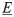
Firing and bursting activity of (4) as a function of z.Top panel shows the values of median ASDRs calculated across 1000 of adjacent and non-overlapping intervals of t (see Methods), each containing k = 30 elements. Bottom panel shows the values of BI (see Methods). The values of median ASDRs and BIs derived for the same values of p, r, and E_ are shown in the same color. Black lines show sample averages.